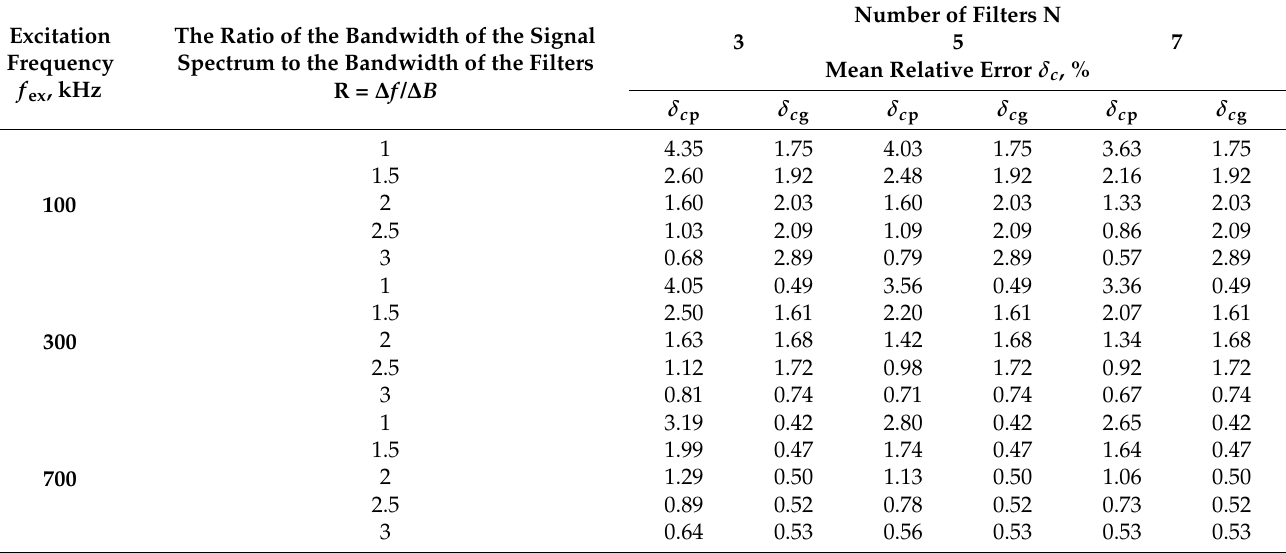
Table 1. The calculations of the mean relative error of the phase and group velocities using the proposed